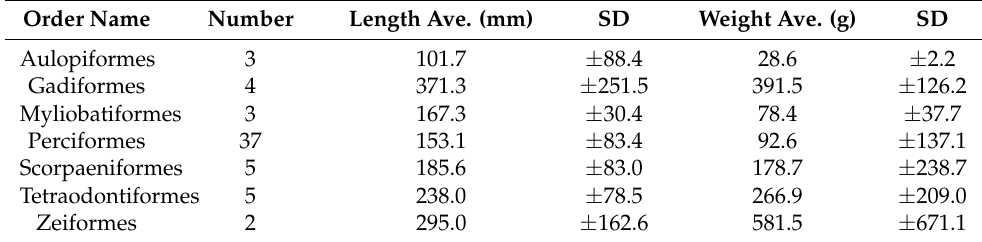
Figure 1. Sea areas around Japan from which the data used in this study originated. Colored circles indicate sampling points, and the abbreviation of the sea area name is listed. Sa is Sagami Bay; Su is Suruga Bay; H is the sea around Hachijojima; and C is the southern coast of Chiba Prefecture, including Tokyo Bay. Table 1. Summary of fish sample characters used for NMR data.